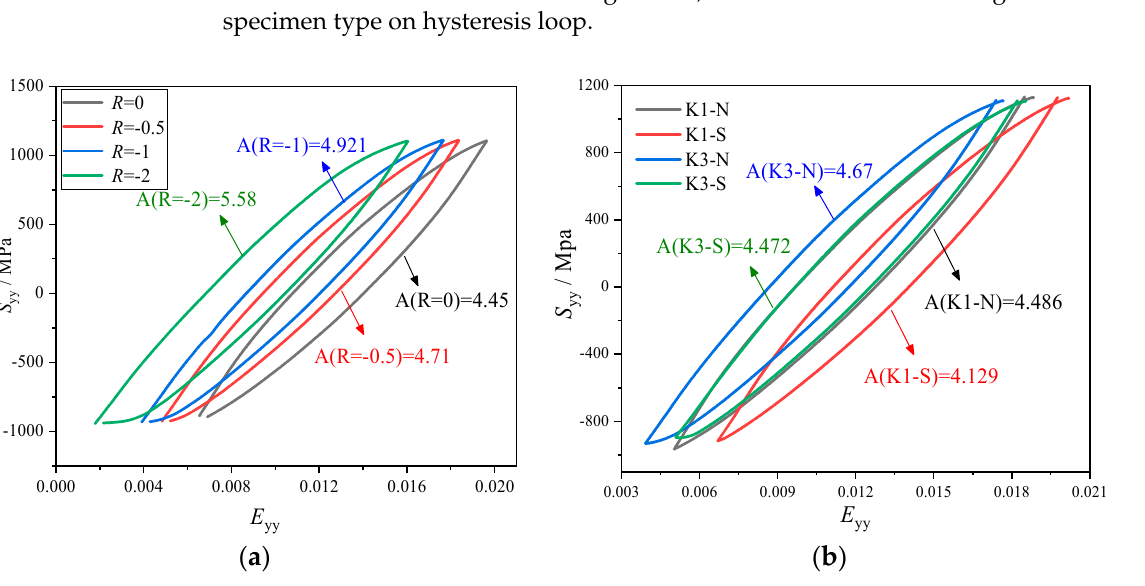
Figure 15. Hysteresis loop: ( a ) effect of loading ratio R ; ( b ) effect of specimen type. Firstly, the hysteresis loop gradually moves to the left as the loading ratio decreases, as shown in Figure 15a. The area enclosed by the hysteresis loop is the strain energy required to drive the crack. The smaller the R , the higher the dissipation energy at the crack tip. Therefore, the negative load can promote damage to the crack tip materials. Then for the effect of specimen type in Figure 15b, the hysteresis loop of the K1-S specimen is at the rightmost, and the K3-N specimen is at the leftmost. The area enclosed by the hysteresis loop of the K3-N specimen is the largest, and the area of the K1-S specimen is the